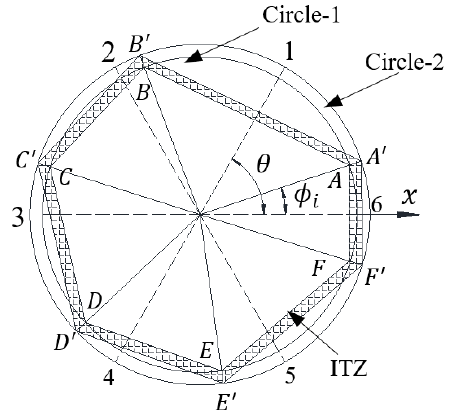
Figure 5. A hexagonal rubber particle and its interface layer.